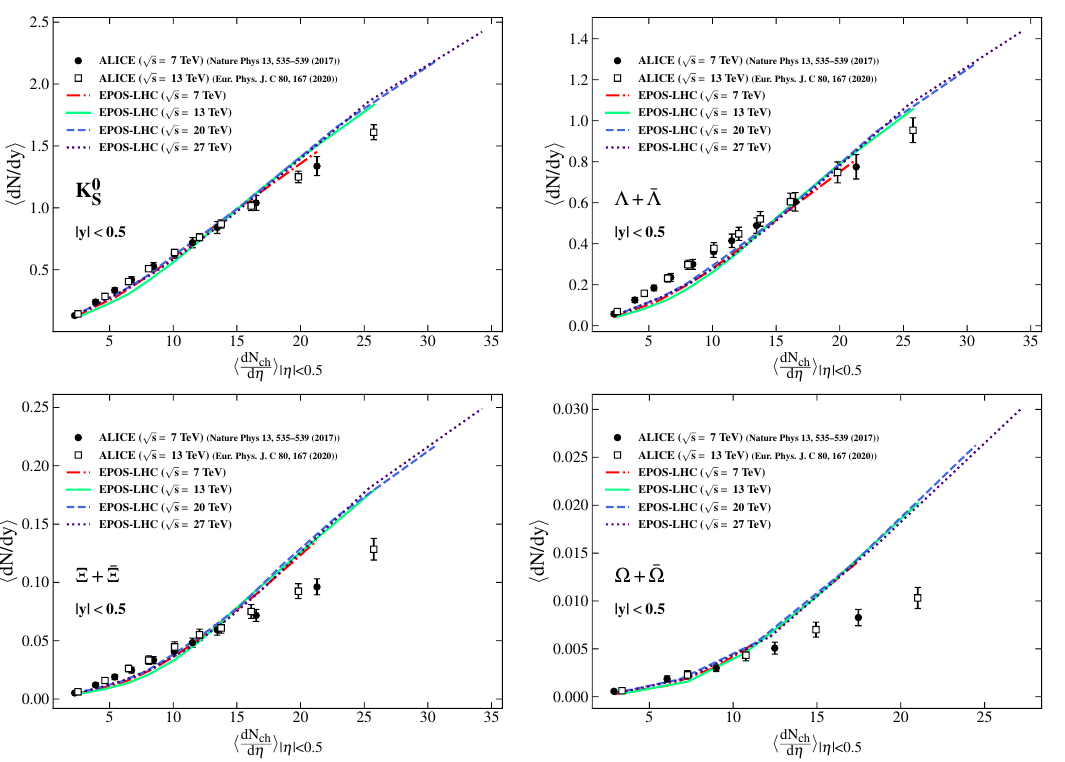
Figure 11. Integrated yields of K 0 √ s = 7 TeV, 13 TeV, 20 TeV, and 27 TeV using PYTHIA8 (Ropes model) [25,26].